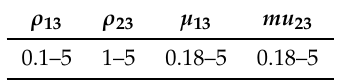
Table 1. Investigated ranges of parameters in the present